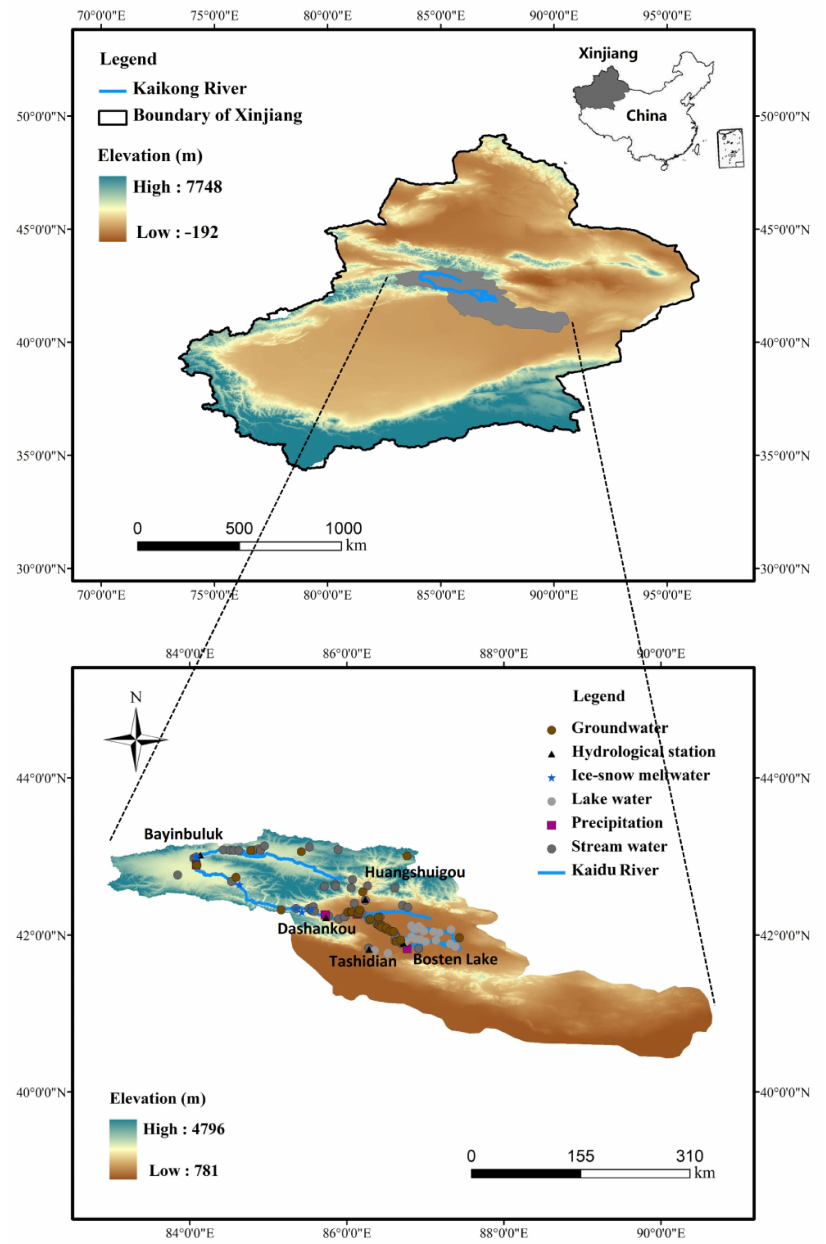
Figure 1. The locations of the sampling sites including geographical features of the study area. The Kaidu River (Kaikong River as shown in the map) Basin is located in Southern Xinjiang, PR